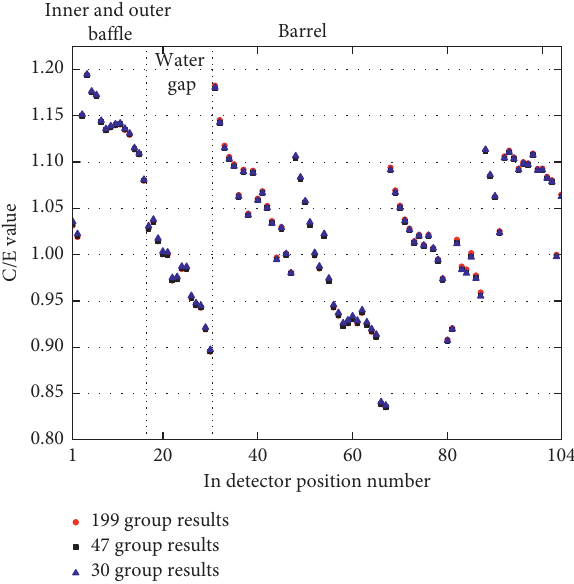
Figure 9: Comparison of group structure of the 115 In(n,n’) 115m In